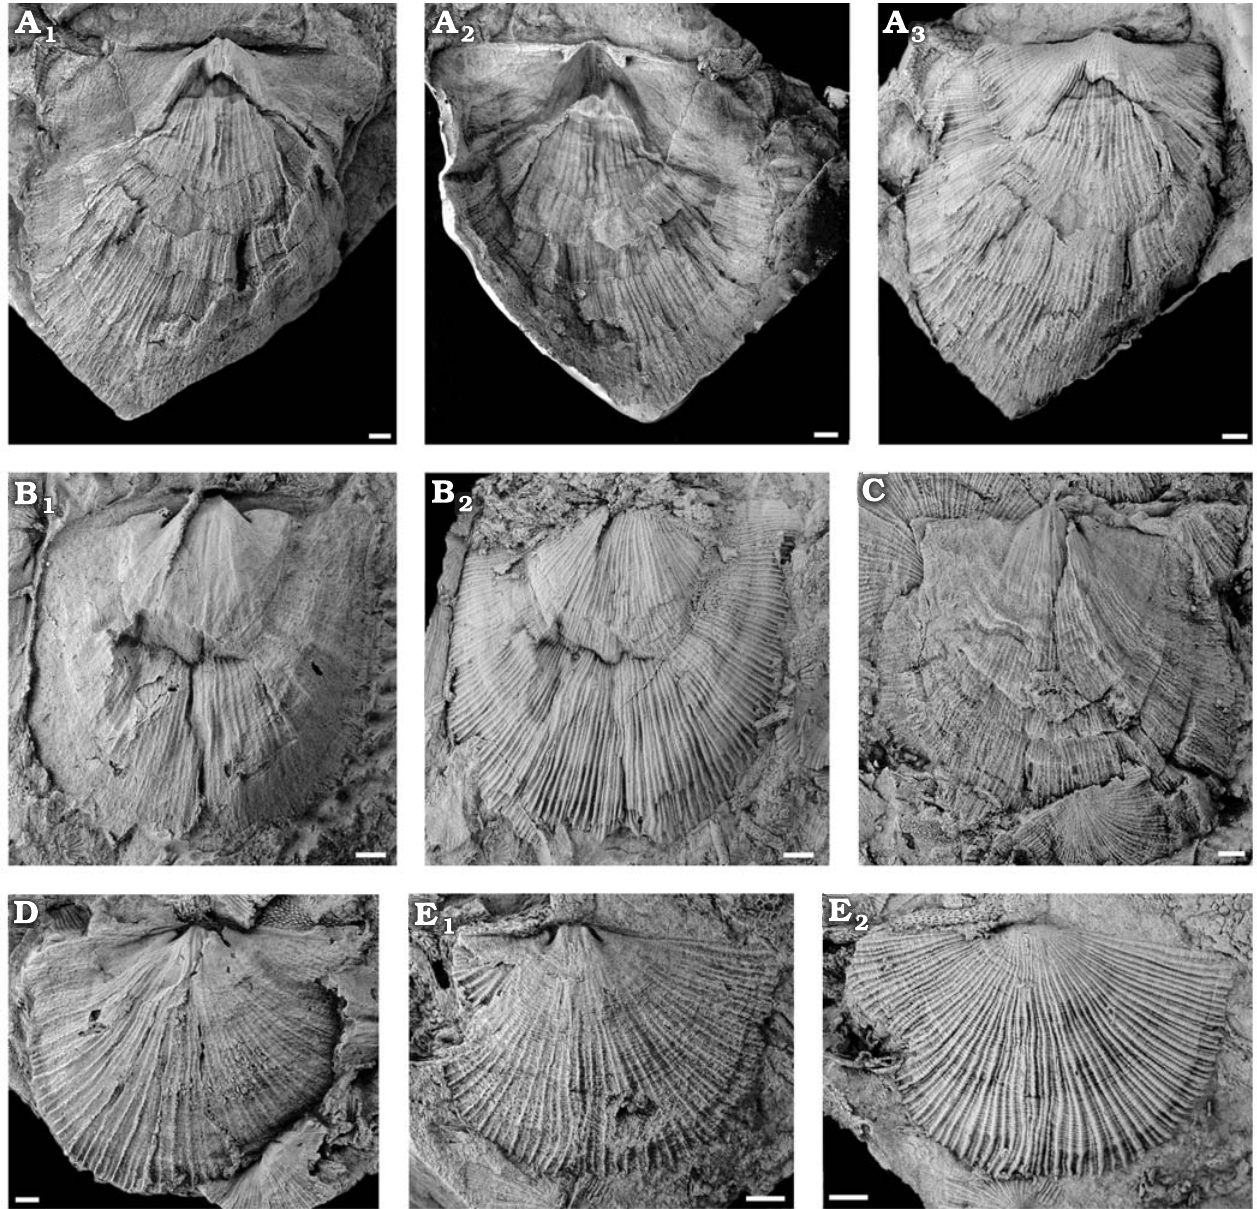
Fig. 12. Ventral valves of rafinesquinine brachiopod Rafinesquina ( Mesogeina ) gabianensis sp. nov.; middle–upper Katian (Ka2–4), Upper Ordovician; Gabian Formation, Montagne Noire, France. A . MPZ 2015/1382, paratype, internal mould (A 1 ) and latex cast of interior (A 2 ) and exterior (A 3 ). B . MPZ 2015/1383, paratype, internal mould (B 1 ) and latex cast of exterior (B 2 ) of a complete valve. C . MPZ 2015/1384, paratype, internal mould. D . MPZ 2015/1385, paratype, internal mould. E . MPZ 2015/1386, paratype, internal mould (E 1 ) and latex cast of exterior (E 2 ) of a small valve. Scale bars 2